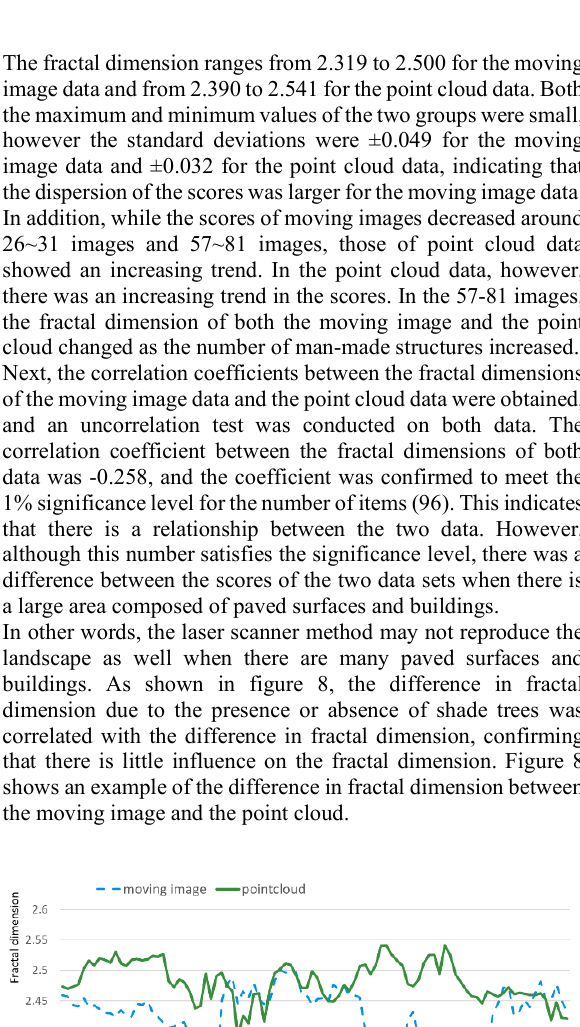
Figure 6 . Example of element-separated images of moving images and point clouds